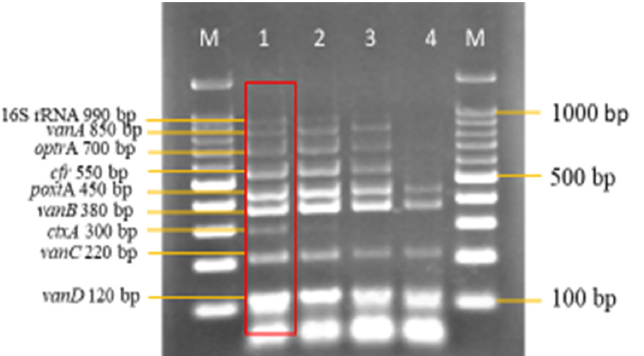
Figure 6. Synthetic dsDNA template concentration optimization in the multiplex PCR. A concentra- tion of 1 ng/ μ L on lane 1 from a range of template concentrations (1 ng/ μ L–1 pg/ μ L) was selected as the optimum template concentration. Lane M: DNA ladder 100 bp plus. Lane 1: 1 ng/ μ L cocktail synthetic DNA template. Lane 2: 100 pg/ µ L cocktail synthetic DNA template. Lane 3: 10 pg/ µ L cocktail synthetic DNA template. Lane 4: 1 pg/ µ L cocktail synthetic DNA